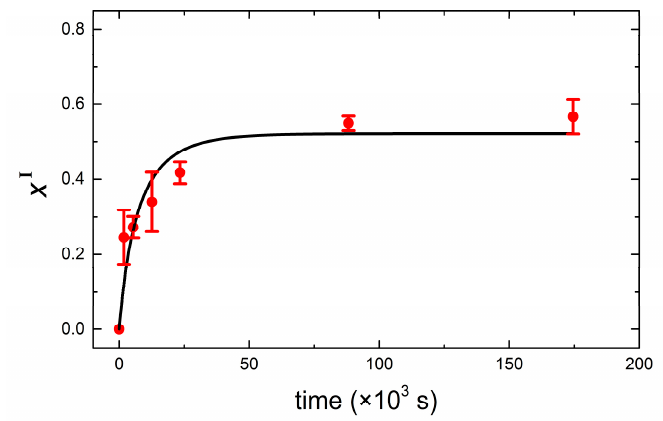
Figure 5. Mole fraction of DMPC in vesicle population I (DPPC vesicles) as a function of time. Red solid dots are experimental points, and the black solid line is the fit to Equation (3).